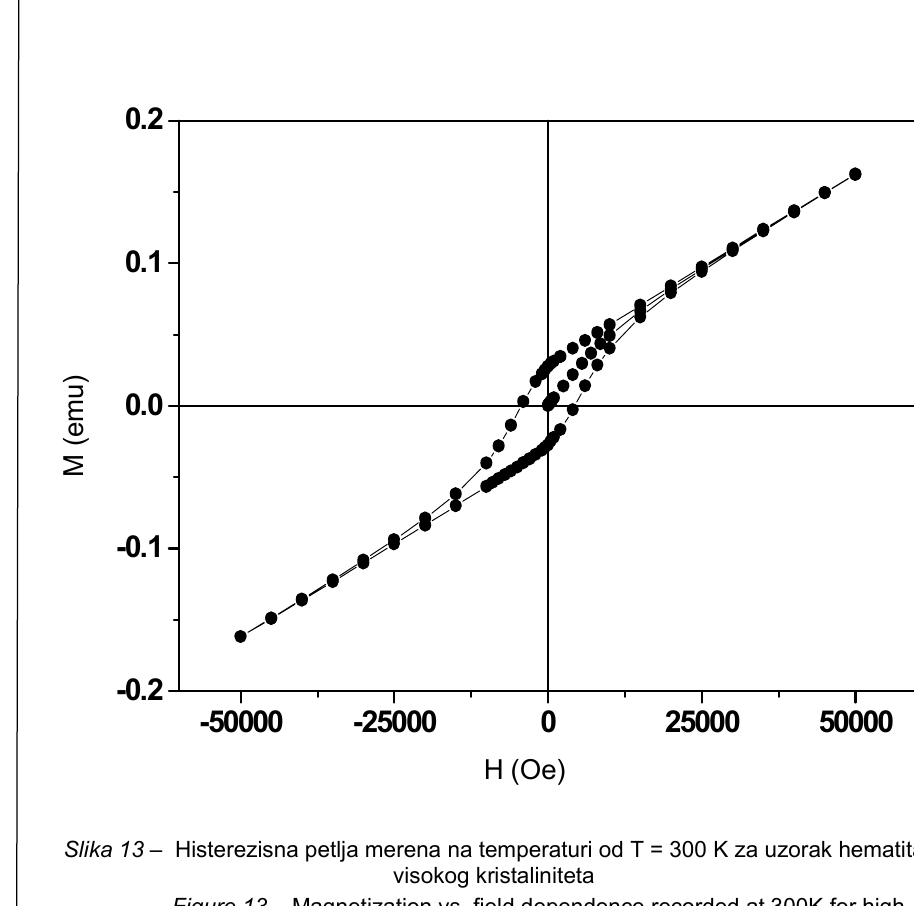
Slika 13 – Histerezisna petlja merena na temperaturi od T = 300 K za uzorak hematita visokog kristaliniteta Figure 13 – Magnetization vs. field dependence recorded at 300K for high cristallinity